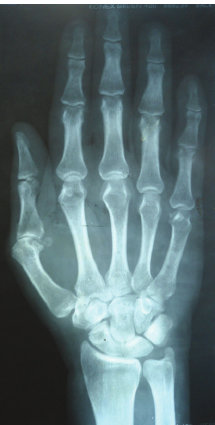
Figure 2: Plain radiograph of the right hand showing no bone erosions.